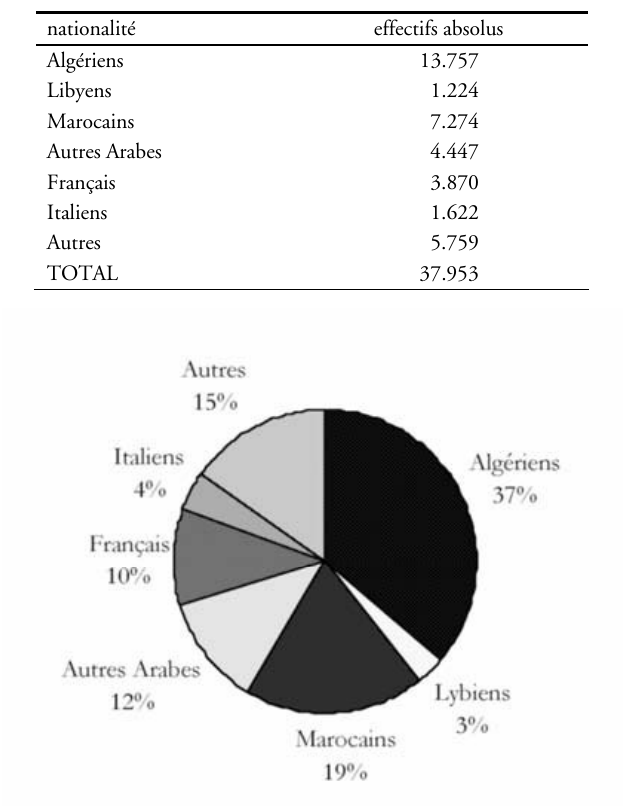
Figure 1 – Présence étrangère en Tunisie par principales nationalités (en pourcentage), 1994 (Source: Ins,